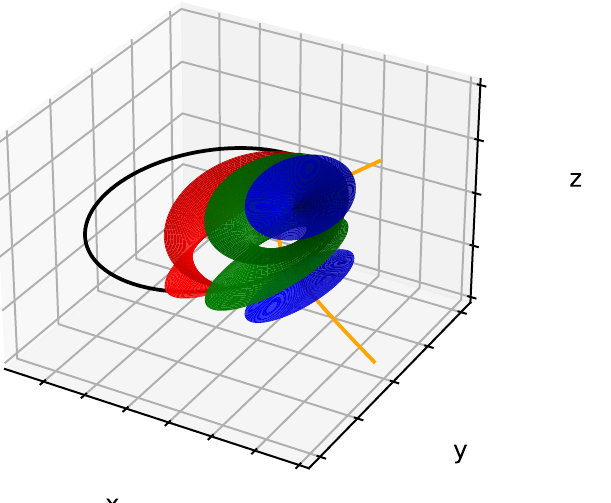
Figure 3. Three smectic layers corresponding to a single focal conic domain as a result of the Dupin cyclides’ equations